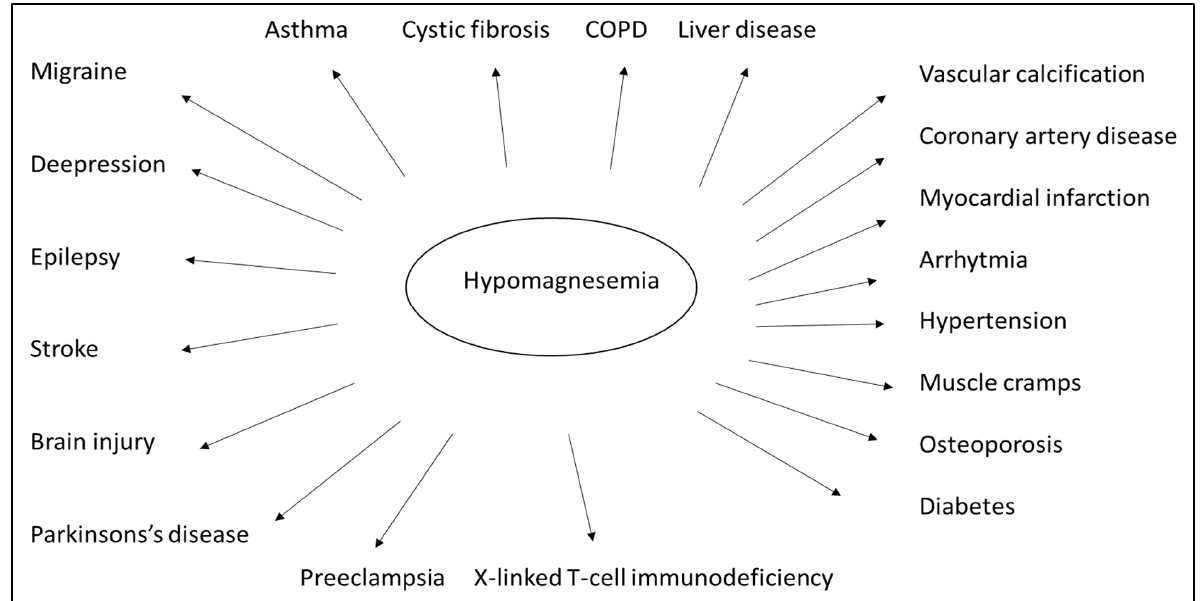
Figure 3. Low levels of magnesium in the body can be associated with many diseases. However, many diseases can be prevented and treated by preventing and correcting hypomagnesemia. (Chronic obstructive pulmonary